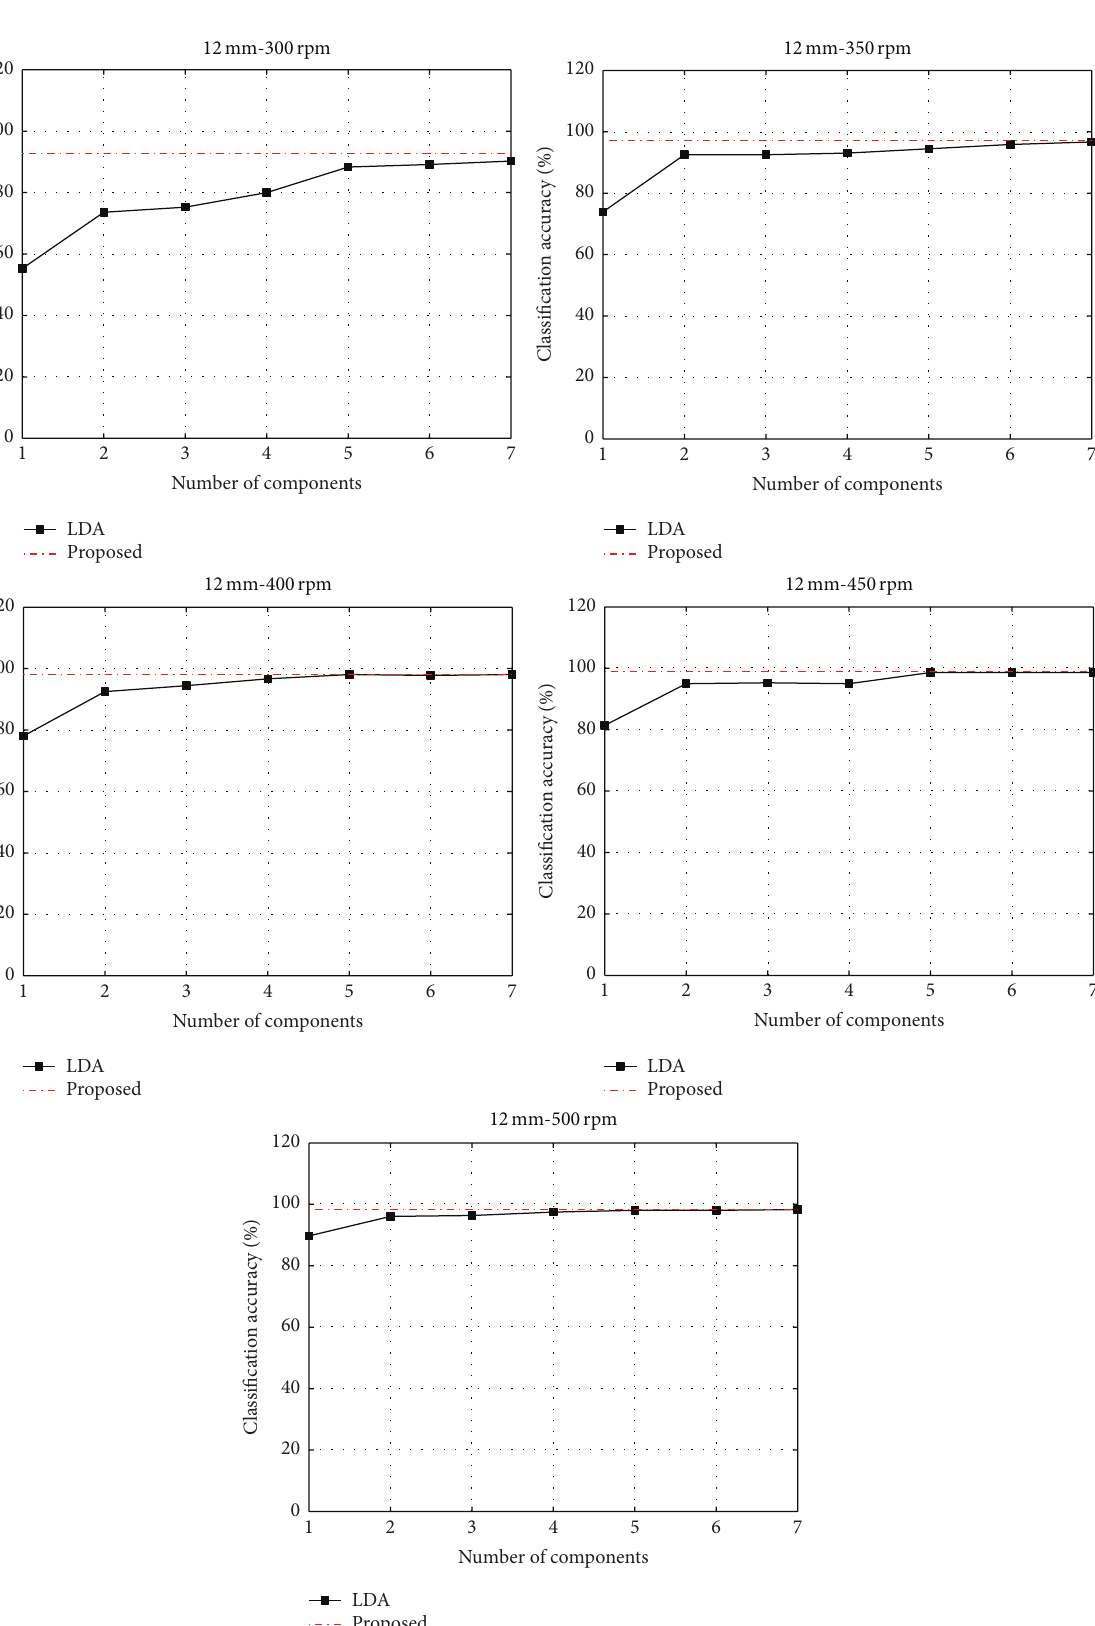
Figure 9: Performance of the proposed feature analysis at a bearing crack size of